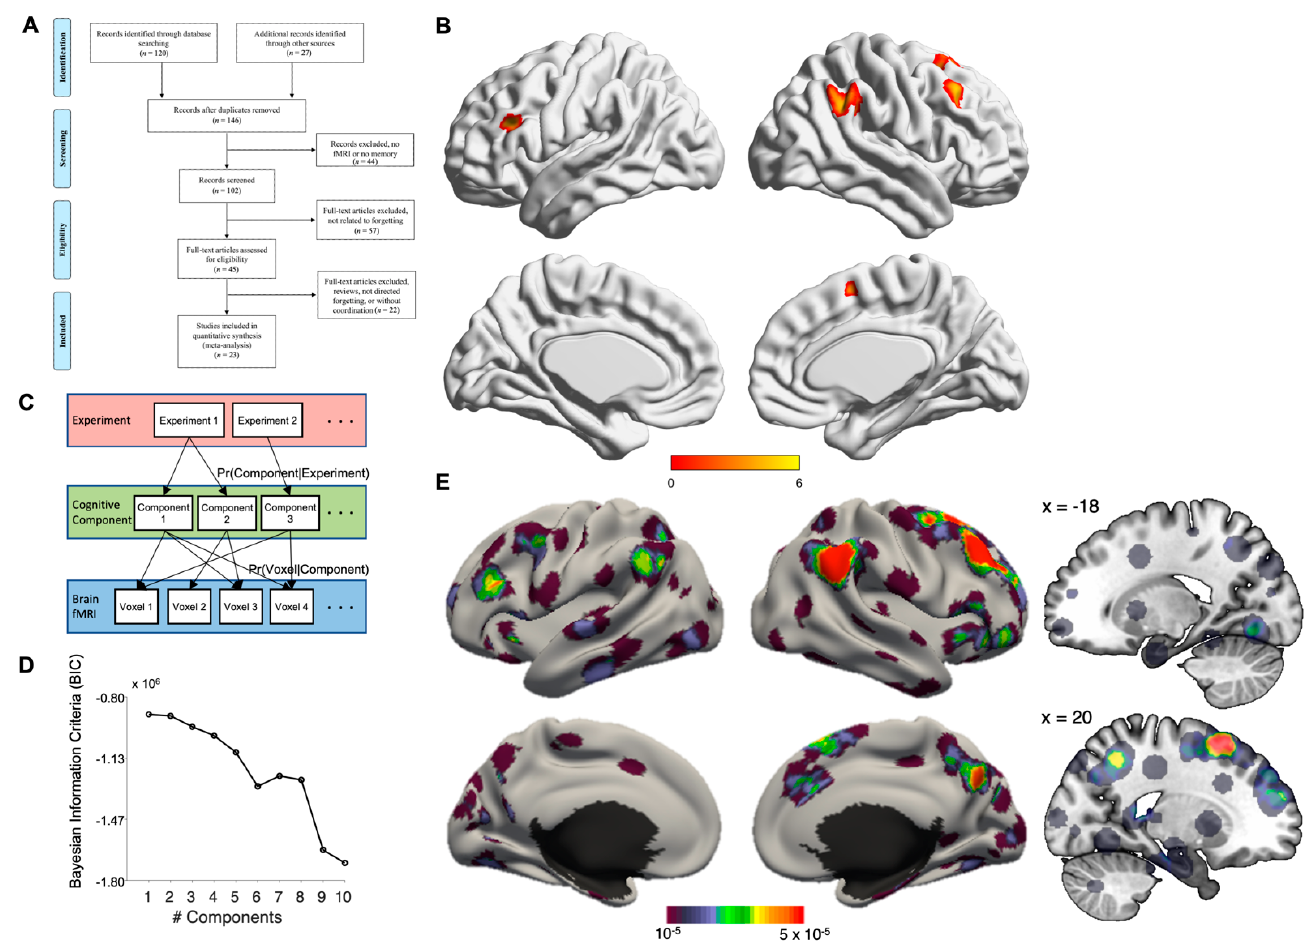
Figure 1. ( A ) PRISMA flow diagram; ( B ) results of ALE analysis; ( C ) Schematic diagram of LDA, ( D ) model selection of LDA results by BIC, and ( E ) LDA results (right hand side sagittal slides showing hippocampal & subcortical activations). Color bars at bottom of panel ( B , E ) represents the display threshold of the blobs presented.